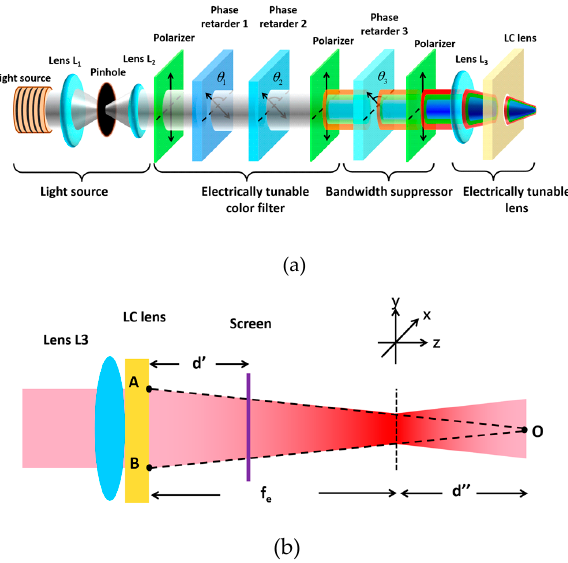
Figure 18. ( a ) Schematic illustration of the assembled optical system for portable LLLT. ( b ) Optical path of the beam as it propagates through lens L3 and LC lens.